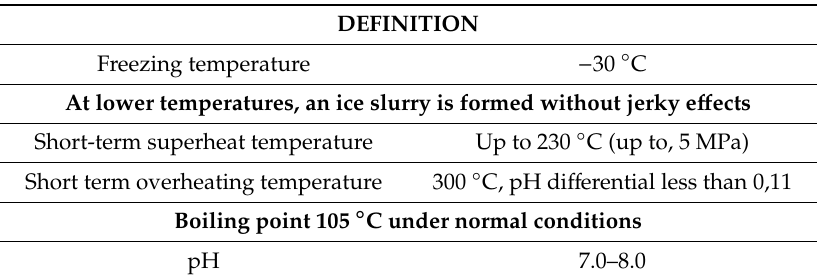
Table 1. Definition of heat-transfer